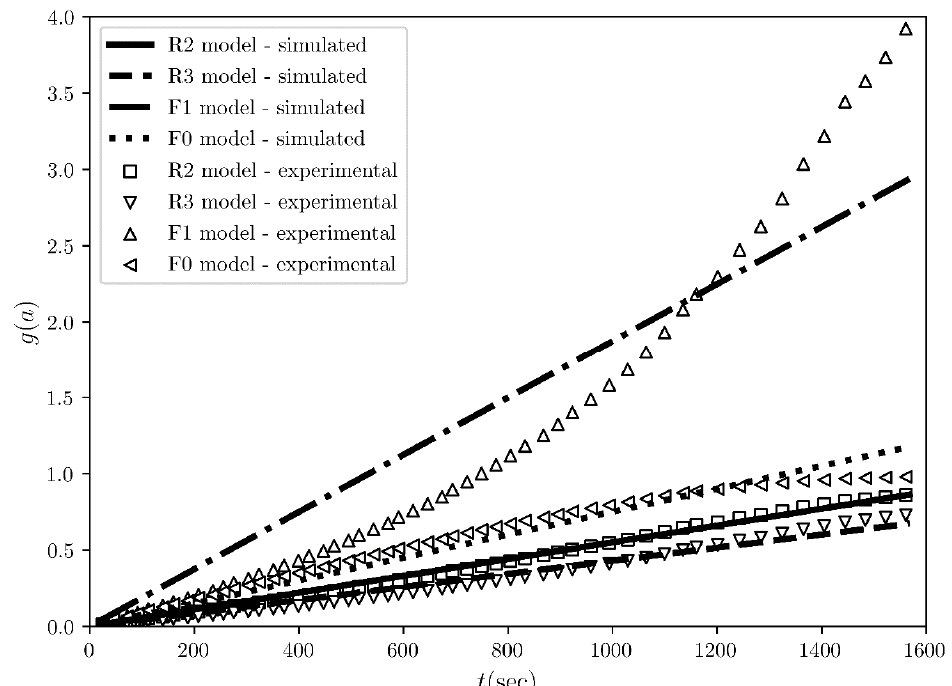
Figure 5. The integral reaction rate time evolution regarding the desolvation of the methanol solvates of ciclesonide at 115 °C. The scatter plots represent the rates evaluated from the experimental conversion fraction measured by L. Zhou et al. [3] while the solid and dashed black lines represent the straight line fits for the “best” four models ranked by COMF, i.e., R2, R3, F1 and F0 models.